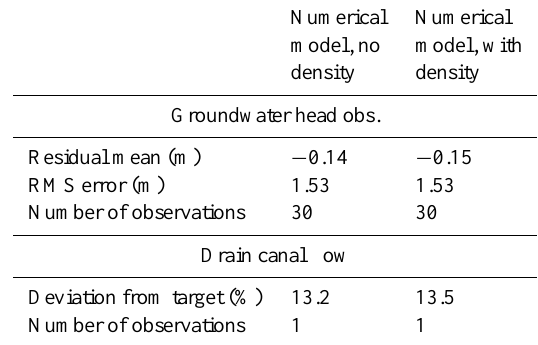
Table 5. Calibration